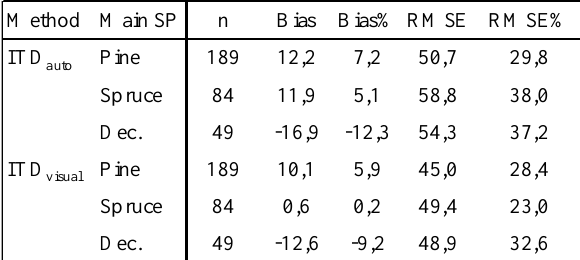
Table 4. Volume (m 3 /ha) estimation accuracy by tree species (Pine, Spruce or Deciduous trees) for ITD auto and ITD visual . ITD visual increased the prediction accuracy especially in mature forests compared to ITD auto (Table 5.). RMSE% for volume at plot level decreased to 27.6% from 34.0% and bias% was decreased in half.